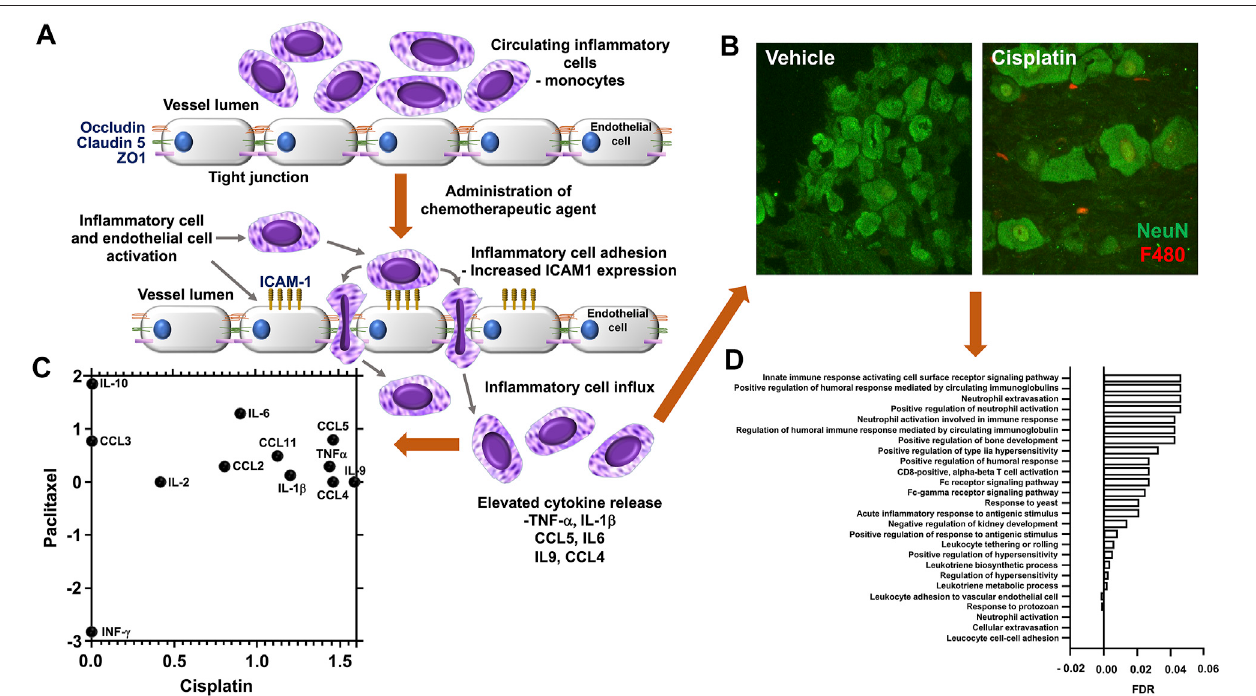
FIGURE 1 | Chemotherapy induced vascular in fl ammation within mouse dorsal root ganglia (A) In rodent models or in human patients administered chemotherapeutic agents display an alternation in the in fl ammatory pro fi le and vascular permeability of the dorsal root ganglia, factors that accompany the presentation of neuropathic pain behavioural phenotypes following exposure to chemotherapeutic agents such as cisplatin, vincristine or paclitaxel the endothelial cells that form the luminalwallofthecapillariesthatresideinthedorsalrootgangliahaveareductionintightjunctionalproteins(ZO1,Occludin,Claudin5)andaccompanyingincrease in adhesion molecules (ICAM1). This promotes the in fi ltration of immunological cell types into the dorsal root ganglia and sensory nerves through increased vascular permeabilityandcelladhesion. (B) Representativeimagesoftheincreasedin fi ltrationofmacrophagesisdisplayed followingbiweeklyintraperitonealinjectionofCisplatin (ip 2 mg/kg for 3 weeks) to C57bl6 mice versus vehicle control group (unpublished data). Accumulation of F4/80 positive in fl ammatory cells (Red) when compared to sham treated rodents, in close apposition to the sensory neurons (green NeuN) in the DRG. In addition, (C) Chemotherapy induced sensory neuroin fl ammation is represented by the pronounced proin fl ammatory environment of the peripheral sensory nervous system. To highlight this, here we present the comparison of available rodent dorsal root ganglia transcriptome datasets, obtained from Gene Expression Omnibus (GEO) following either cisplatin [GSE125003 (Starobova et al., 2020)] or Paclitaxel [GSE185084 (Lessans et al., 2019)] administration, comparing log 2-fold change of Fragments Per Kilobase Million (FPKM) values from vehicle controls. Our reanalysis of this data demonstrates an increase in proin fl ammatory mediator expression in particular IL6. (D) Furthermore, utilising FPKM values to summarise the transcriptome following cisplatin treatment from two independent rodent studies [GSE64174 (unpublished) and GSE125003 (Starobova et al., 2020)] highlights an alteration in the dorsal root ganglia transcriptome pro fi le. In both studies797 genes were identi fi ed with altered gene expression (FPKM value) greater than 1 log fold changefromcontrolssamples).Additionally,usinggeneenrichmentanalysis(STRING)postcisplatintreatmenttheidenti fi ed797geneshadastrongassociationwiththe promotion of pro-in fl ammatory process [Gene Ontology Biological Process of less than 0.5 Log p -value with False Discovery Rate